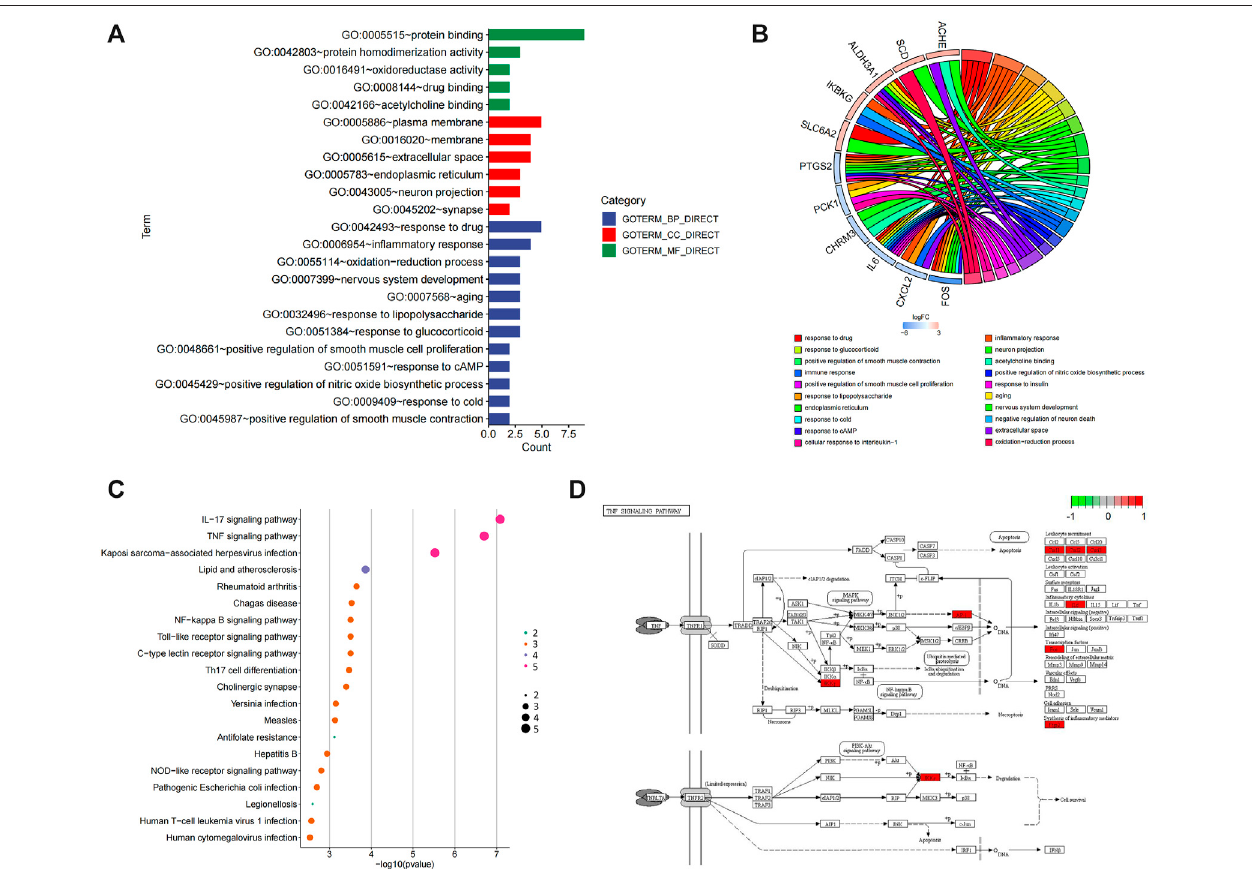
FIGURE 4 | GO and KEGG enrichment of N&P. The core intersected genes (N&P) were analyzed by GO enrichment (A,B) . The green, red, and blue boxes represented biological process, cellular component, and molecular function, respectively. The top fi ve results of GO enrichment were shown. Then, N&P were analyzed by KEGG enrichment (C) . The top twenty signaling pathways were listed and the pink circles represented the top three signaling pathways. The TNF signaling pathway, one of the top two signaling pathways, was analyzed (D) . The red boxes represented the core genes (N&P) in the TNF signaling pathway.